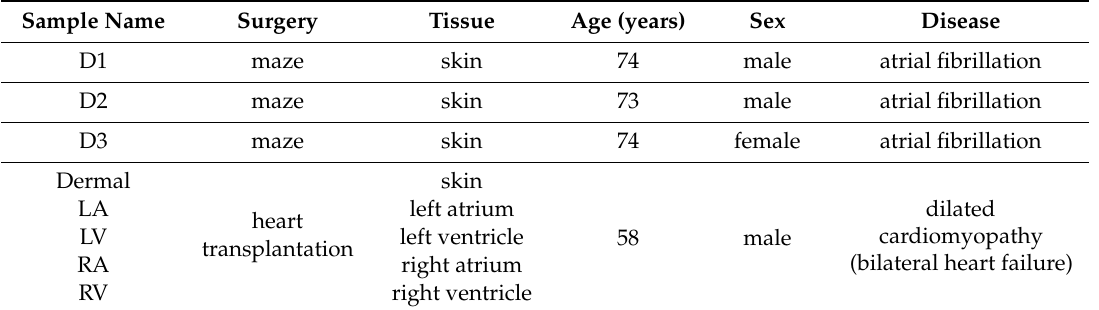
Table 1. Patient